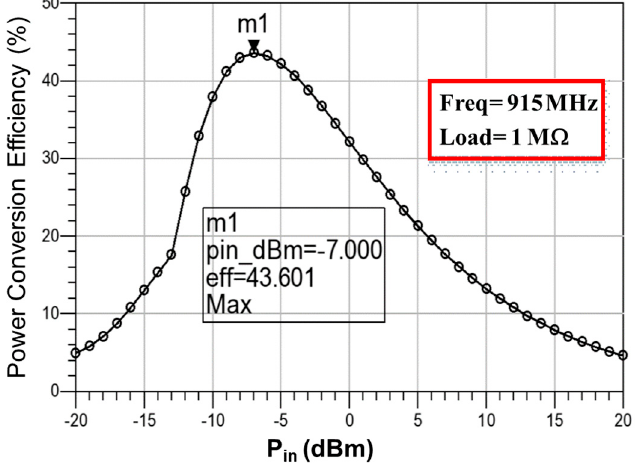
Figure 12. Simulated line regulation of the proposed LDO regulator. Figure 13. Simulated load regulation of the proposed LDO regulator.